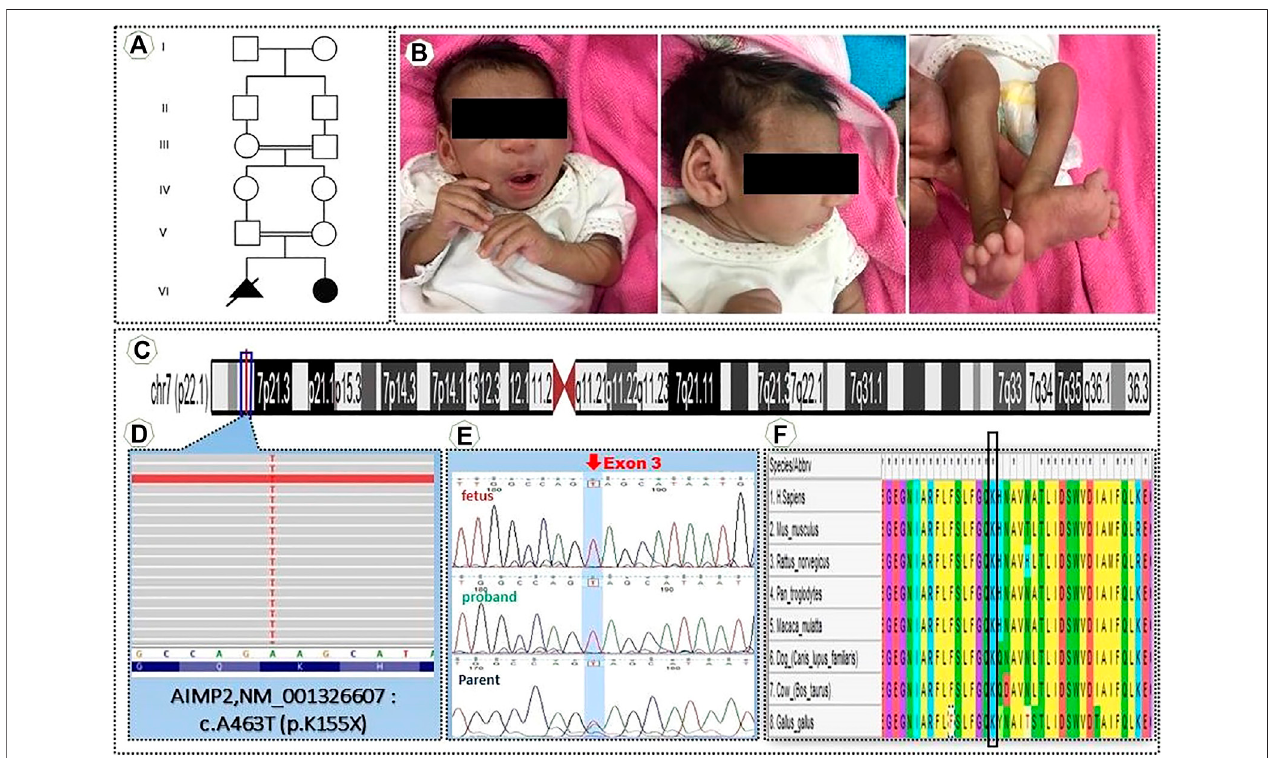
FIGURE1|(A) Pedigreesofthefamily (B) Clinicalmanifestationsoftheproband (C) AnIntegrativeGenomicViewer(IGV)ofhomozygousnonsensevariantAIMP2 ″ NM001326607c.A463T,K155X (D) Positioninthehomozygousstateinexon3ofthevariantc.A463T(NM_001,326,607)ofAIMP2[p.(K155X)]. (E) Sangersequencing of genomic DNA con fi rmed the presence of a homozygous mutation in the proband and heterozygous mutation in the parents. (F) This alignment shows this position (variant) highly conserved between vertebrates.